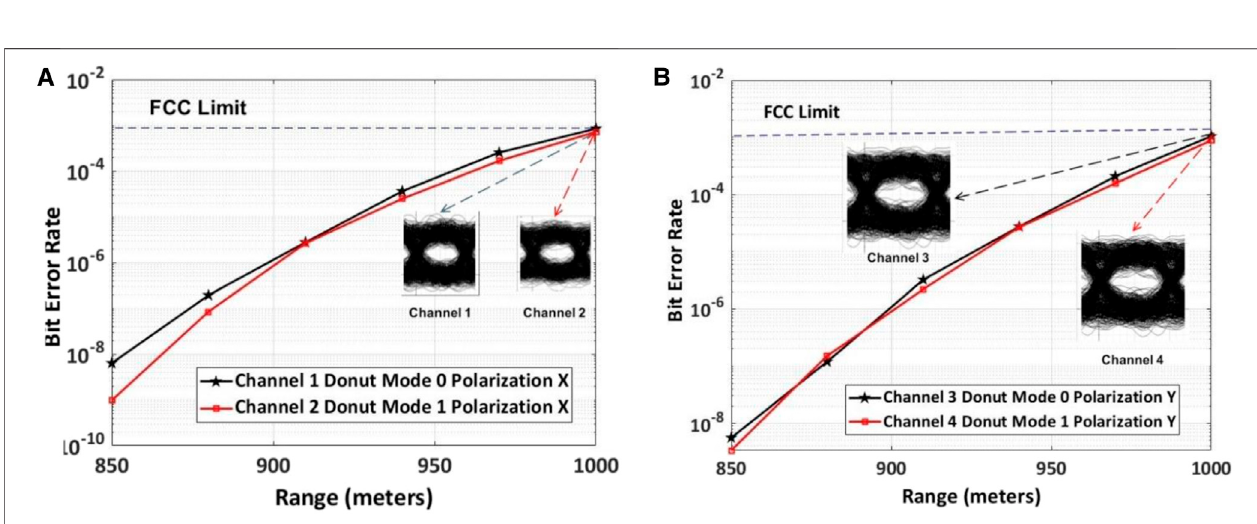
Frontiers in Physics |